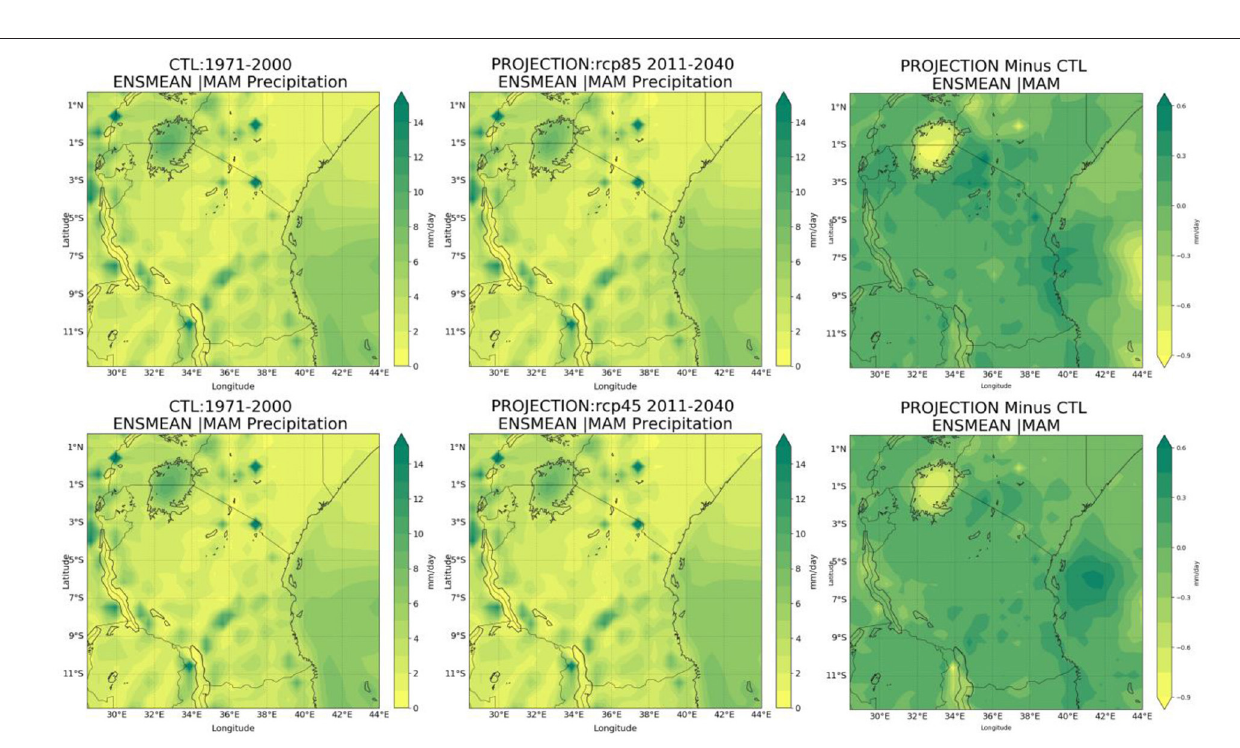
Frontiers in Environmental Science |